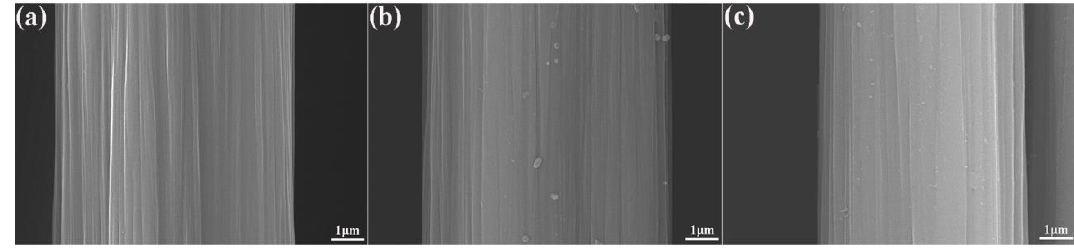
Figure 2. SEM images of different CFs surface: ( a ) untreated CF, ( b ) CF-PDA, and ( c ) CF-PDA/SiO 2 .